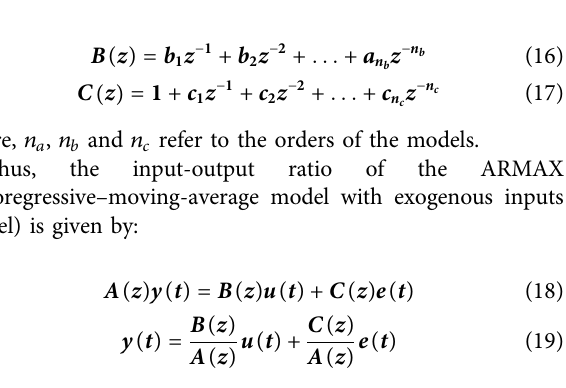
FIGURE 1 | (A) System identi fi cation process. (B) Steps of the system identi fi cation procedure. (Source: Vasquez et al., 2008).